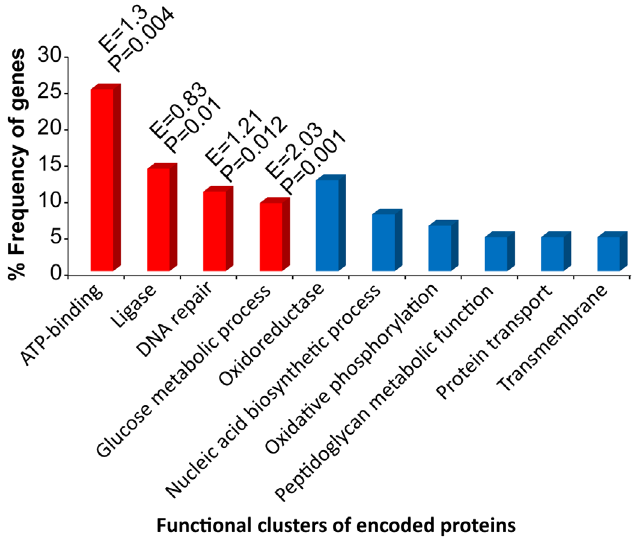
Fig 4. Functional clustering of encoded proteins for 67 candidate genes. These genes potentially evolved under positive selection for accumulating convergent mutations within subspecies I. Enrichment scores (E) and P-values are shown for the enriched or overrepresented functional clusters (in